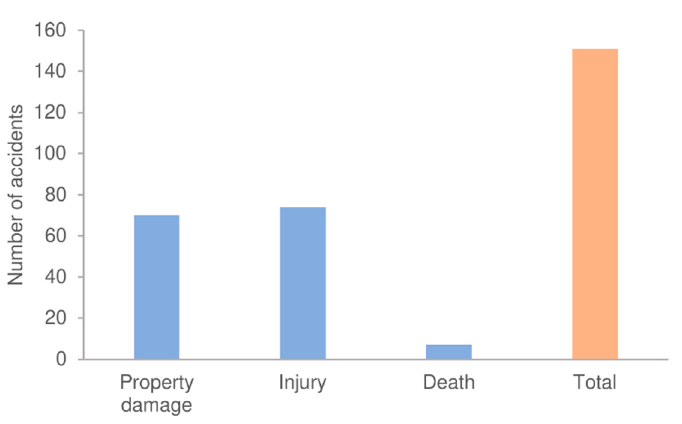
Figure 4. Numbers and types of accidents on Buraydah Ring Road in year 2017.